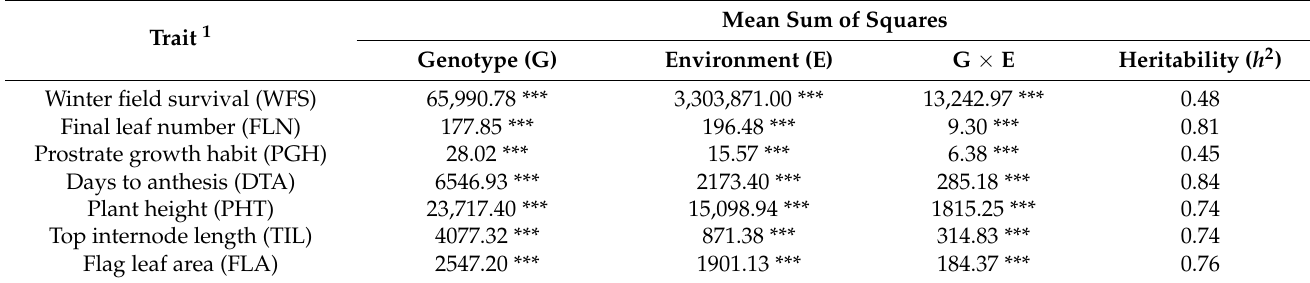
Table 4. Analysis of variance and heritability of WFS and developmental